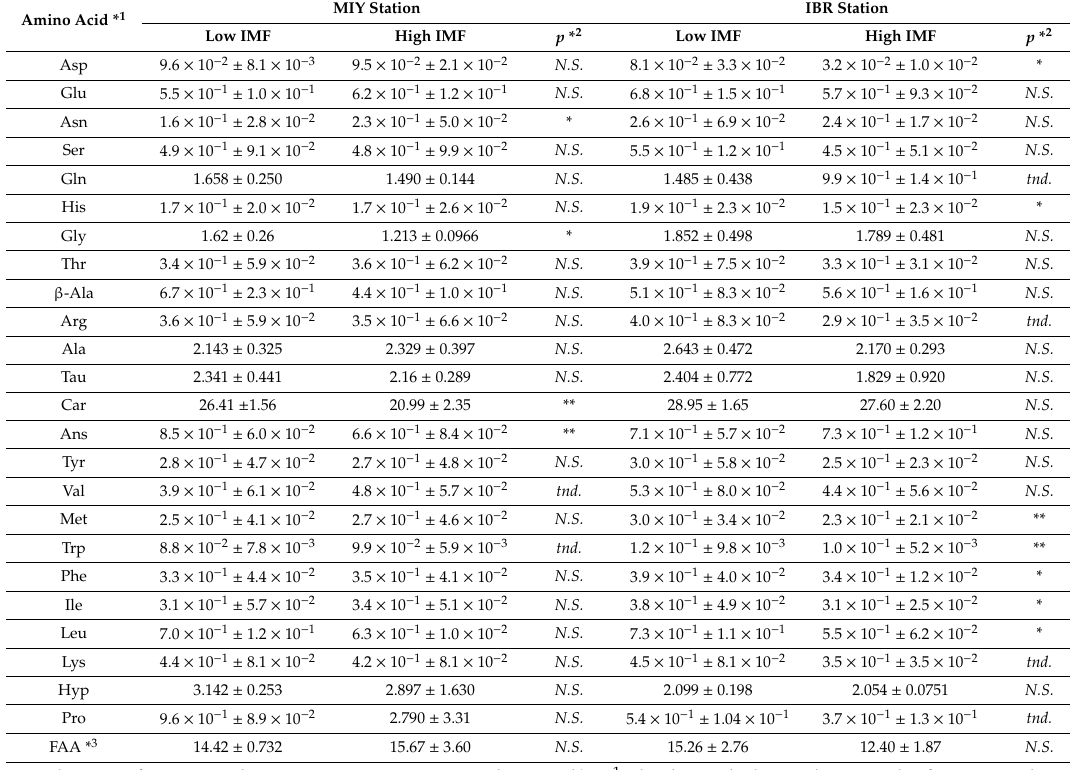
Table 4. Analysis of amino acid contents in the loin eye muscle tissues from two stations. Amino Acid *